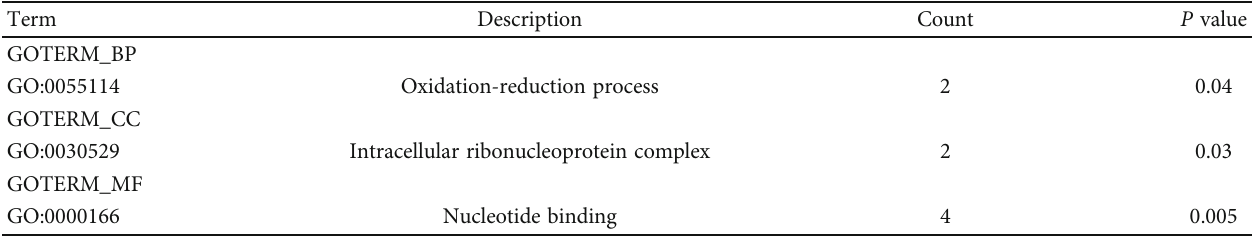
Table 2: An investigation of the GO of downregulated genes related to